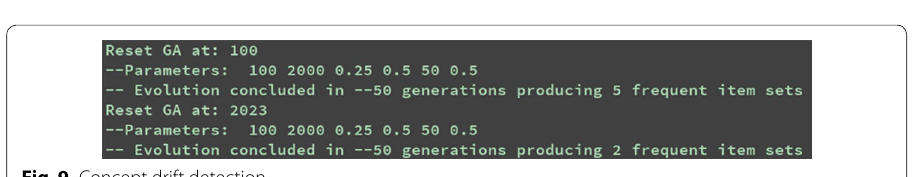
Fig. 9 Concept drift